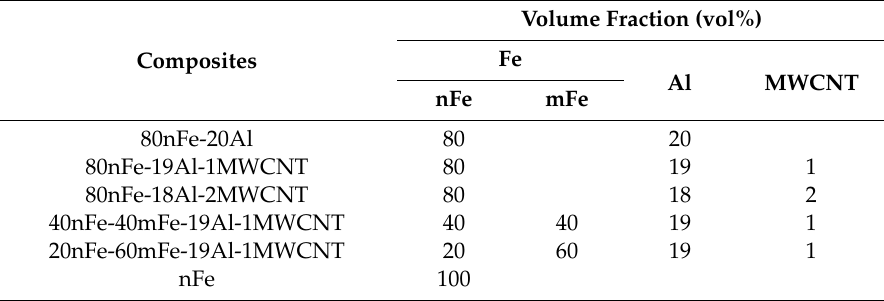
Table 1. Volume ratio of the nanocomposite materials.